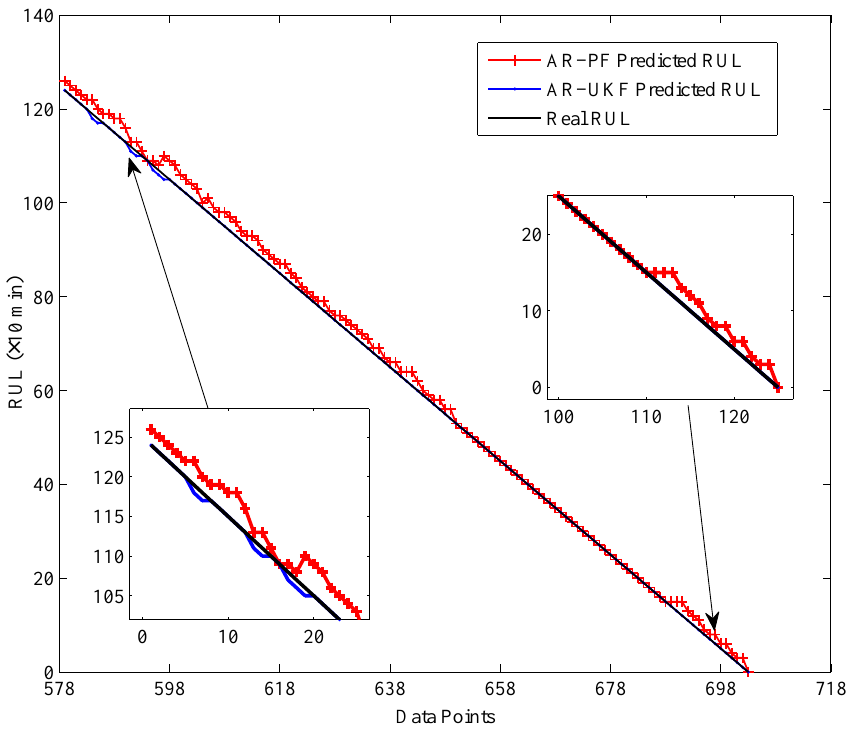
Figure 8. The RUL prediction curve of different models.